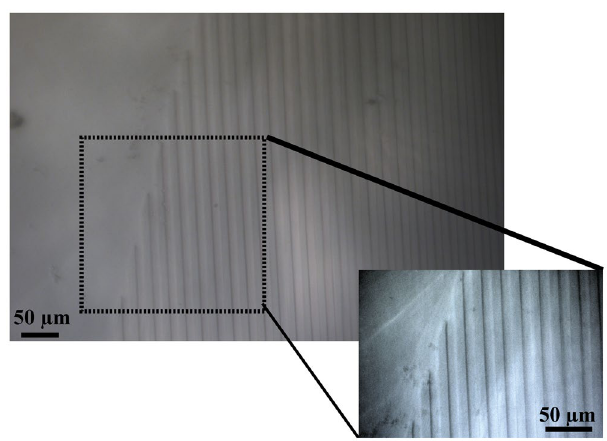
Figure 5. Optical micrographs of micro-patterned hydrated PAm